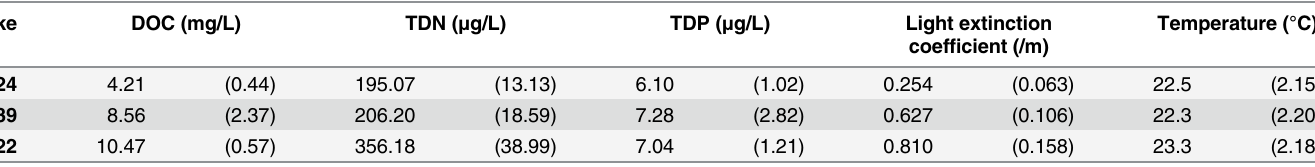
Table 1. Mean nutrient content, light extinction coefficients, and daily temperature (standard deviation) measured periodically June-August 2012.